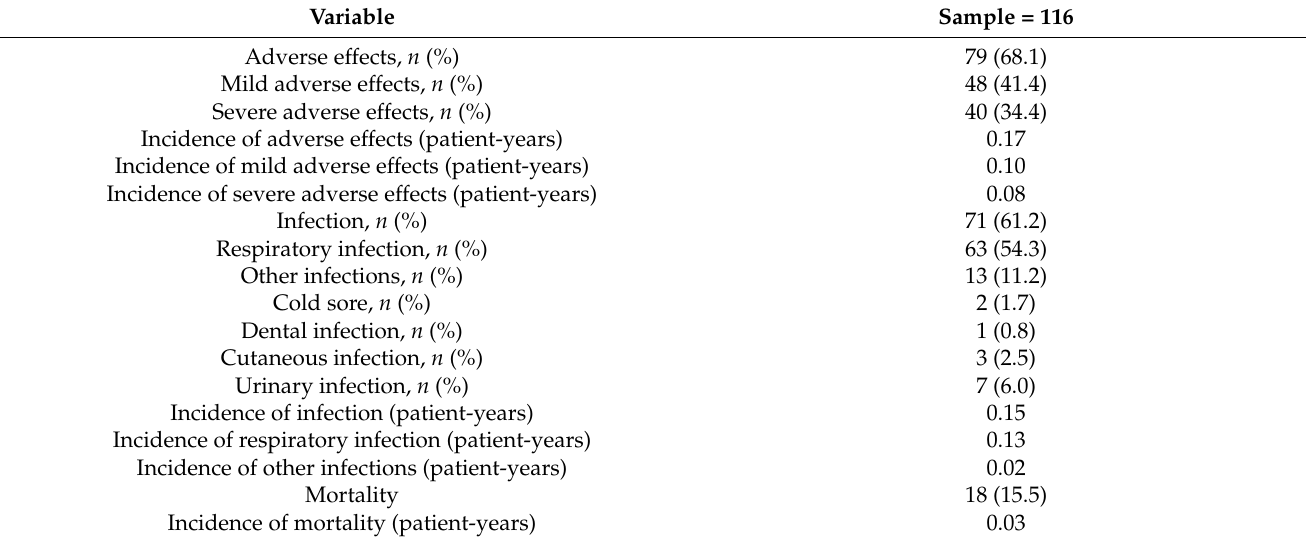
Table 6. Adverse effects in patients with RA-ILD taking